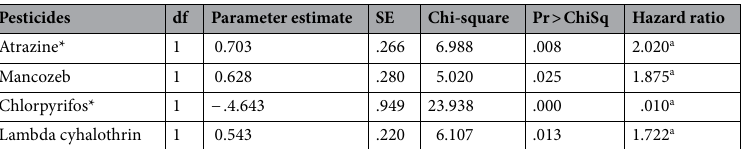
Table 3. Cox PH model summary of species effect on survival of fingerlings. *Hazard ratio constant with time. a Statistical significant ( p < 0.05). b Not significant ( p > 0.05).